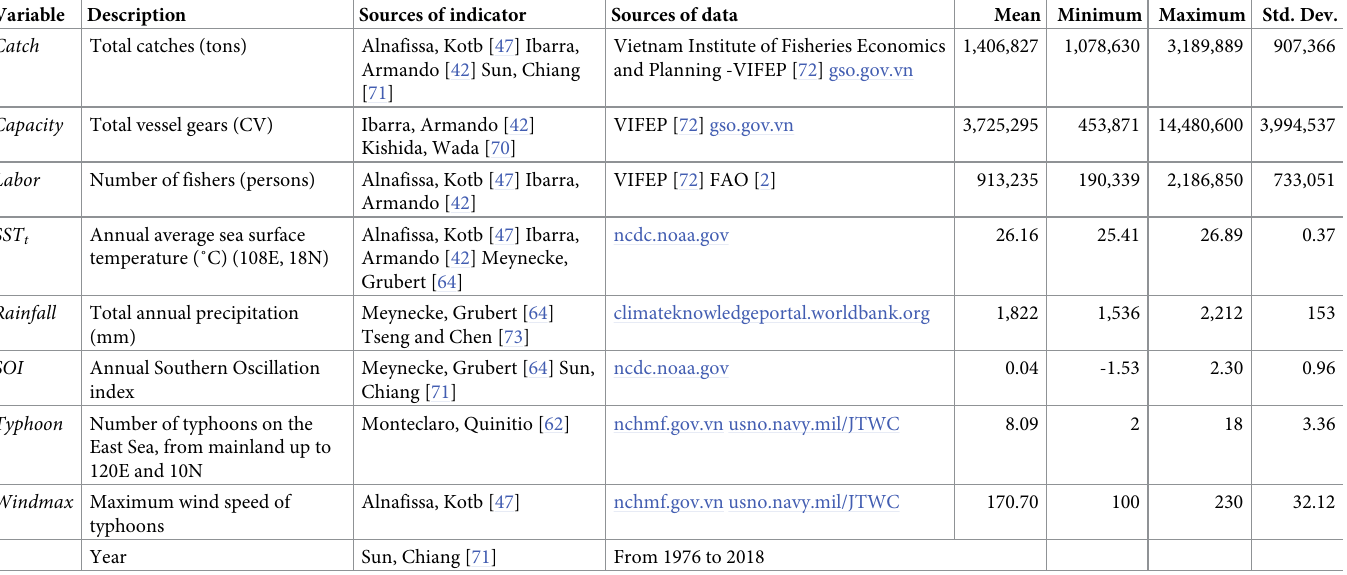
Table 1. Variable descriptions and